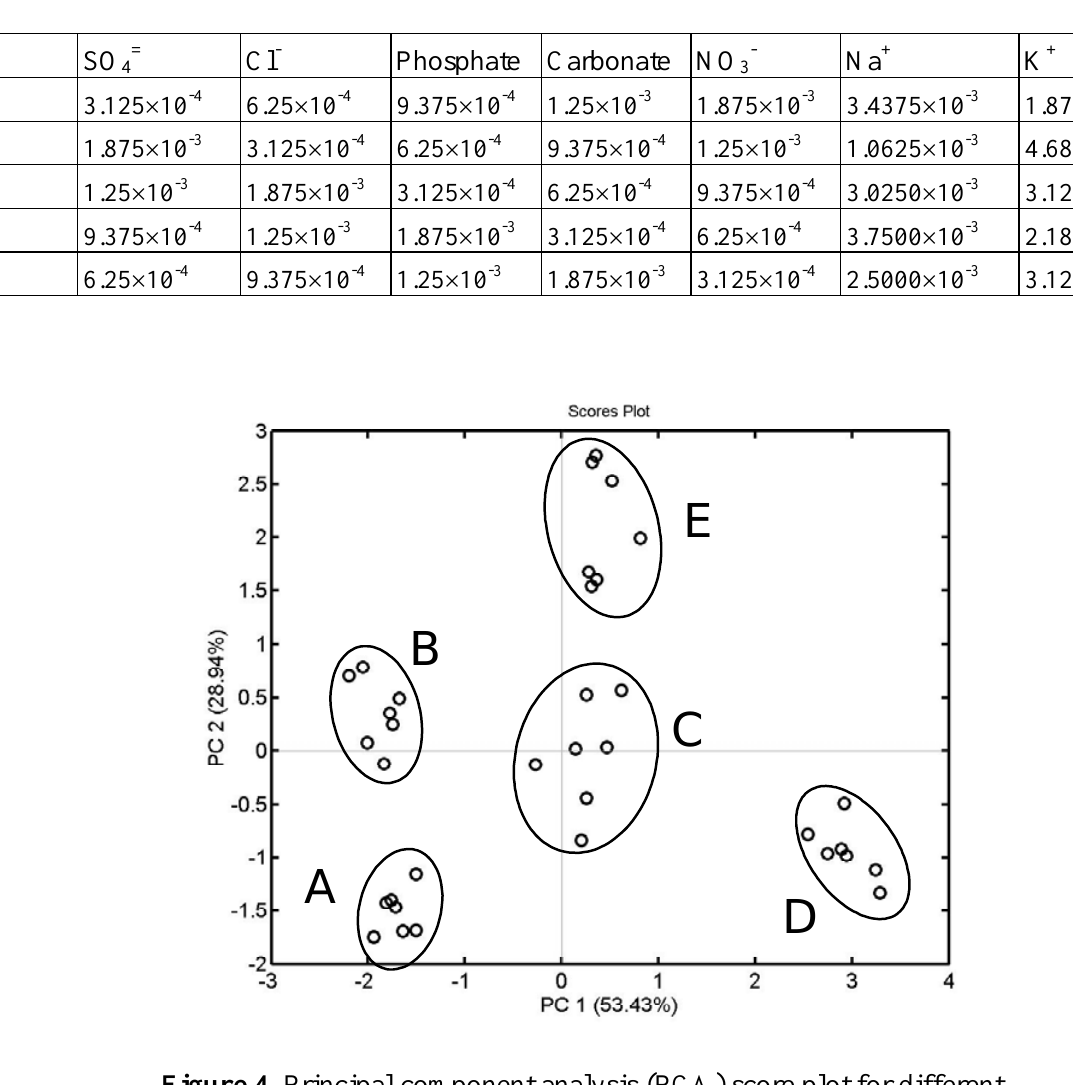
Table 3. Anion and cation concentrations (in mol/L) for the five (labeled A to –E) aqueous mixtures.